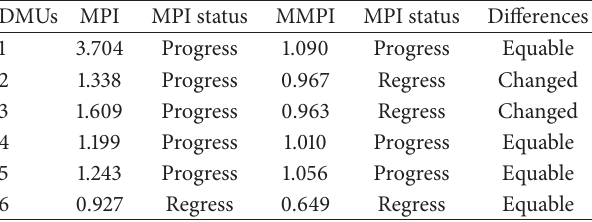
Table 10: Modified Malmquist Productivity